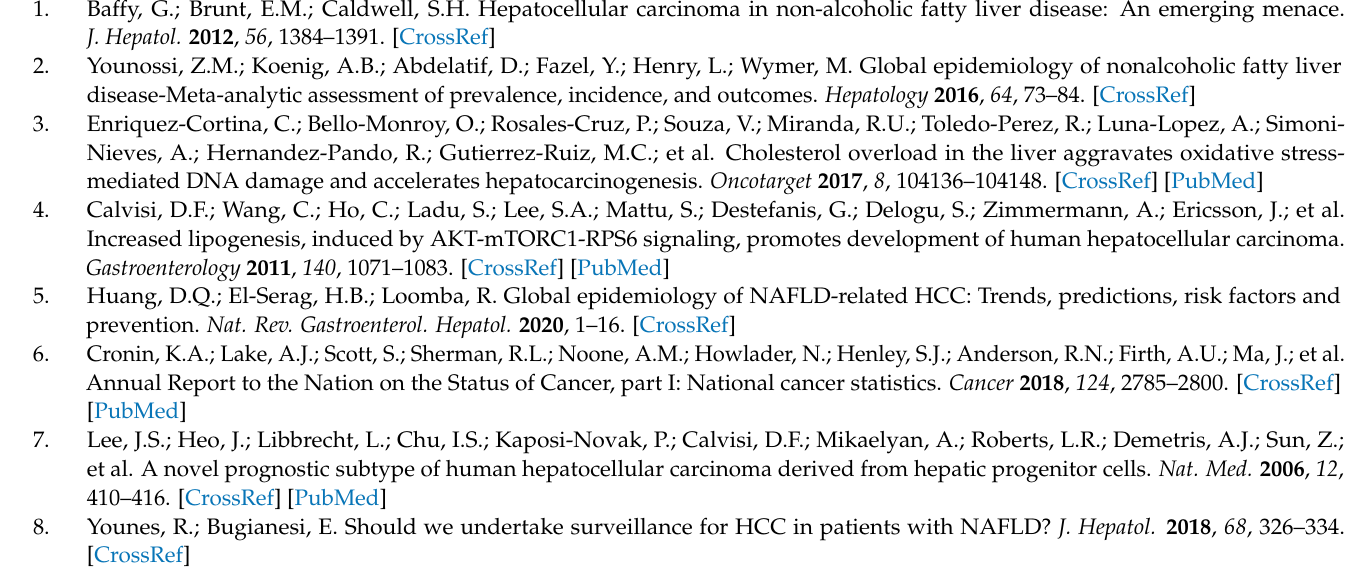
& p < 0.05 vs. diet control. Figure S3. Expression of the 4 genes differentially overexpressed related to high lipid overload with potential relevance in tumor promotion: Mthfd1, Slc41a3, Fabp5, Igdcc4. Each graph plots the individual data points, the superimpose horizontal line indicates the arithmetic mean and error bars showing ± SEM. ** p < 0.01 vs. CW group.Table S1: Mice groups under different diets and treatments. Table S2: Primers used in the study. Table S3: Antibodies used in the study. Table S4: Gene expression profile of W/DEN vs. CW/DEN. Table S5: Gene expression profile of HC/DEN vs. CW/DEN. Table S6: Gene expression profile shared by W/DEN vs.